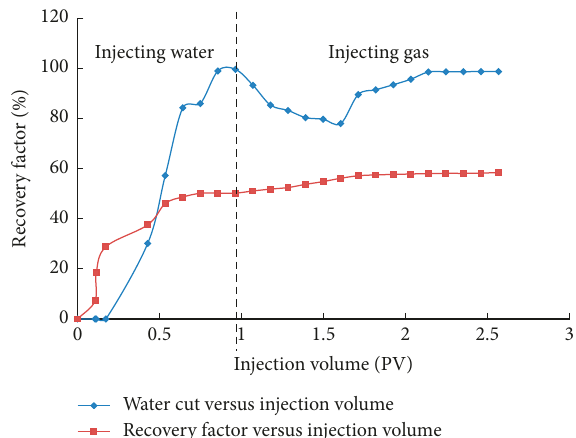
Figure 6: Curve of the recovery factor during CO flooding after water flooding. 2